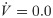
Performance of the autocatalytic controller when the compensatory flux is generated within the cellular volume (Eqs 34, 35, 59 and 60).Phase 1: constant volume V and constant k3. Initial concentrations and rate constant values: V0 = 25.0, V˙=0.0, A0 = 0.0, E0 = 0.0, M0 = 4 × 104, N0 = 1 × 106, k2 = 1.0, k3 = 2.0, k3˙=0.0, k4 = 20.0, k5 = 1 × 10−6, k6 = 10.0, k7 = 1 × 10−6, kEin=kEout=1×10−5. The controller moves A to its theoretical set-point at Asettheor=(k4/k6)=2.0 (Eq 37). Phase 2: rate constants remain the same as in phase 1, but V increases linearly with V˙=2.0, while k3 remains constant at k3 = 2.0. The controller is able to maintain A at Asettheor in agreement with Eq 37. Phase 3: V continues to increase with the same speed while k3 now linearly increases with k3˙=1.0. As indicated by Eq 38 the controller keeps A at Asettheor as k3 increases.